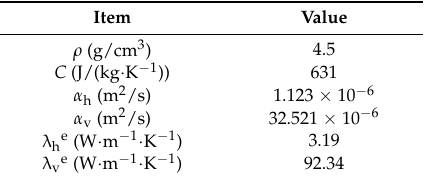
Table 1. Data about experimental value of thermal